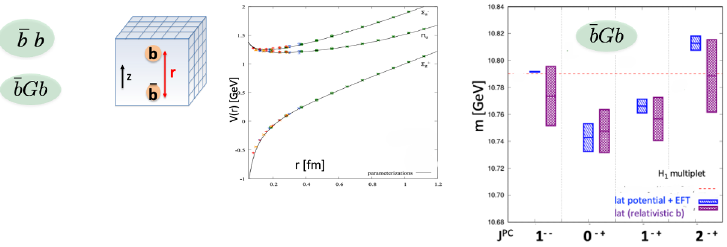
Figure 8. Left: The potentials related to hybrids in quenched QCD from a recent lattice simulation with fine lattice spacings [34]. Right: Masses of ¯ bGb hybrids (update of [35, 36]) from older potentials [37] (blue) and from relativistic b quarks [24] (violet).